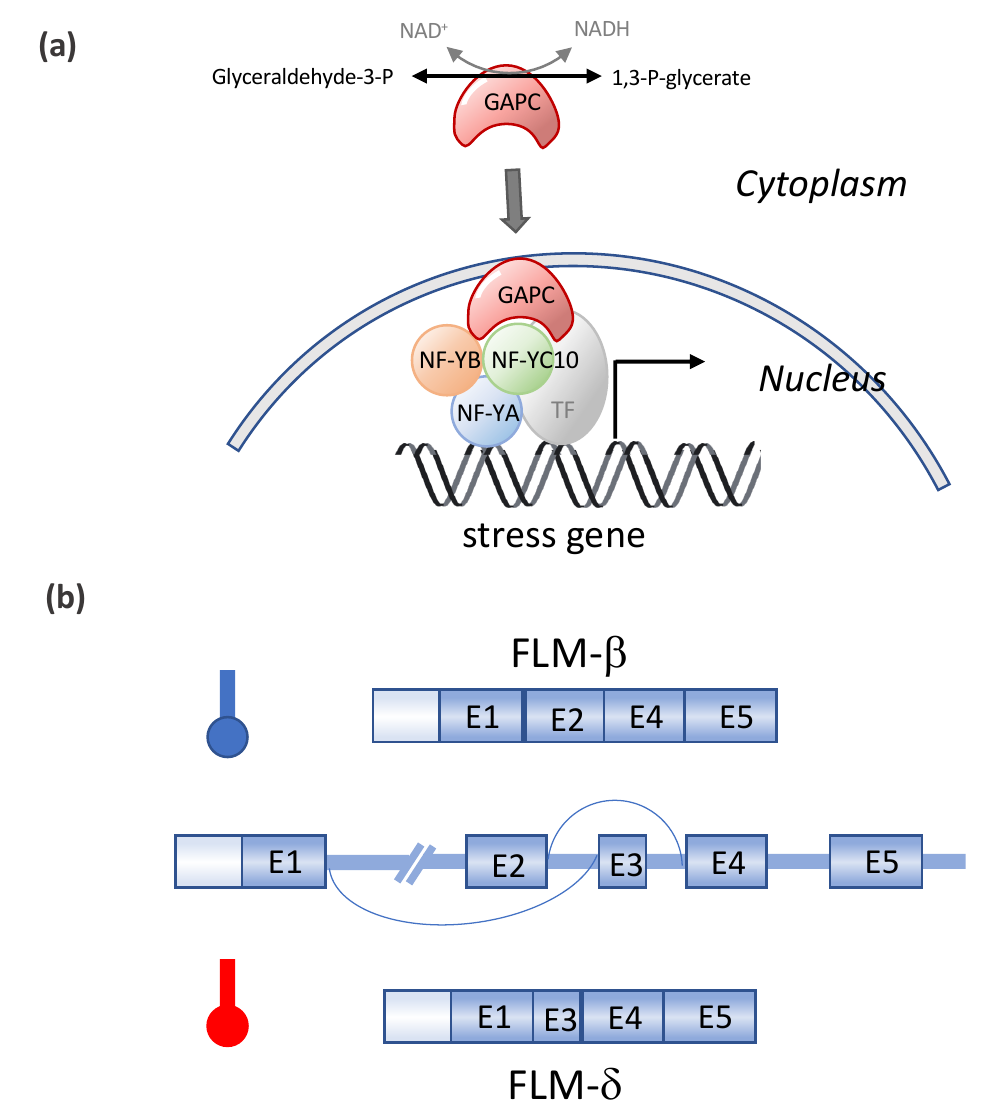
Figure 5. Moonlighting of cytosolic glyceraldehyde-3-phosphate dehydrogenase and the temperature-dependent alternative splicing of FLOWERING LOCUS M (FLM) in Arabidopsis. ( a ) Moonlighting of cytosolic glyceraldehyde-3-phosphate dehydrogenase (GAPC) (Based on Kim et al., 2020 [64]). The heat responses require GAPC and NF-YC10 interactions, and GAPC, which is normally located in the cytosol, enters the nucleus in response to heat. In the nucleus, GAPC binds to transcription factor NF-YC10 to increase the expression of heat-inducible genes, rendering Arabidopsis tolerant to heat stress. ( b ) Alternative splicing of FLM in response to the temperature. Modified from Capovilla et al., 2017 [74]. FLM has two splice variants, FLM- β and FLM- δ , in Arabidopsis, resulting from the temperature-dependent alternative splicing of FLM pre-mRNA via a mutually exclusive event (with Exon 2 or 3). The ratio of the two splicing isoforms, FLM- β /FLM- δ , fine-tunes the flowering time and is regulated by the ambient